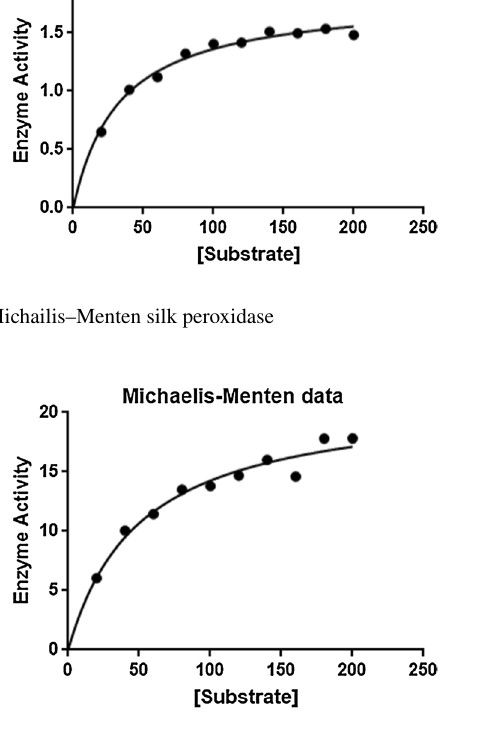
Fig. 8 Michailis–Menten husk peroxidase